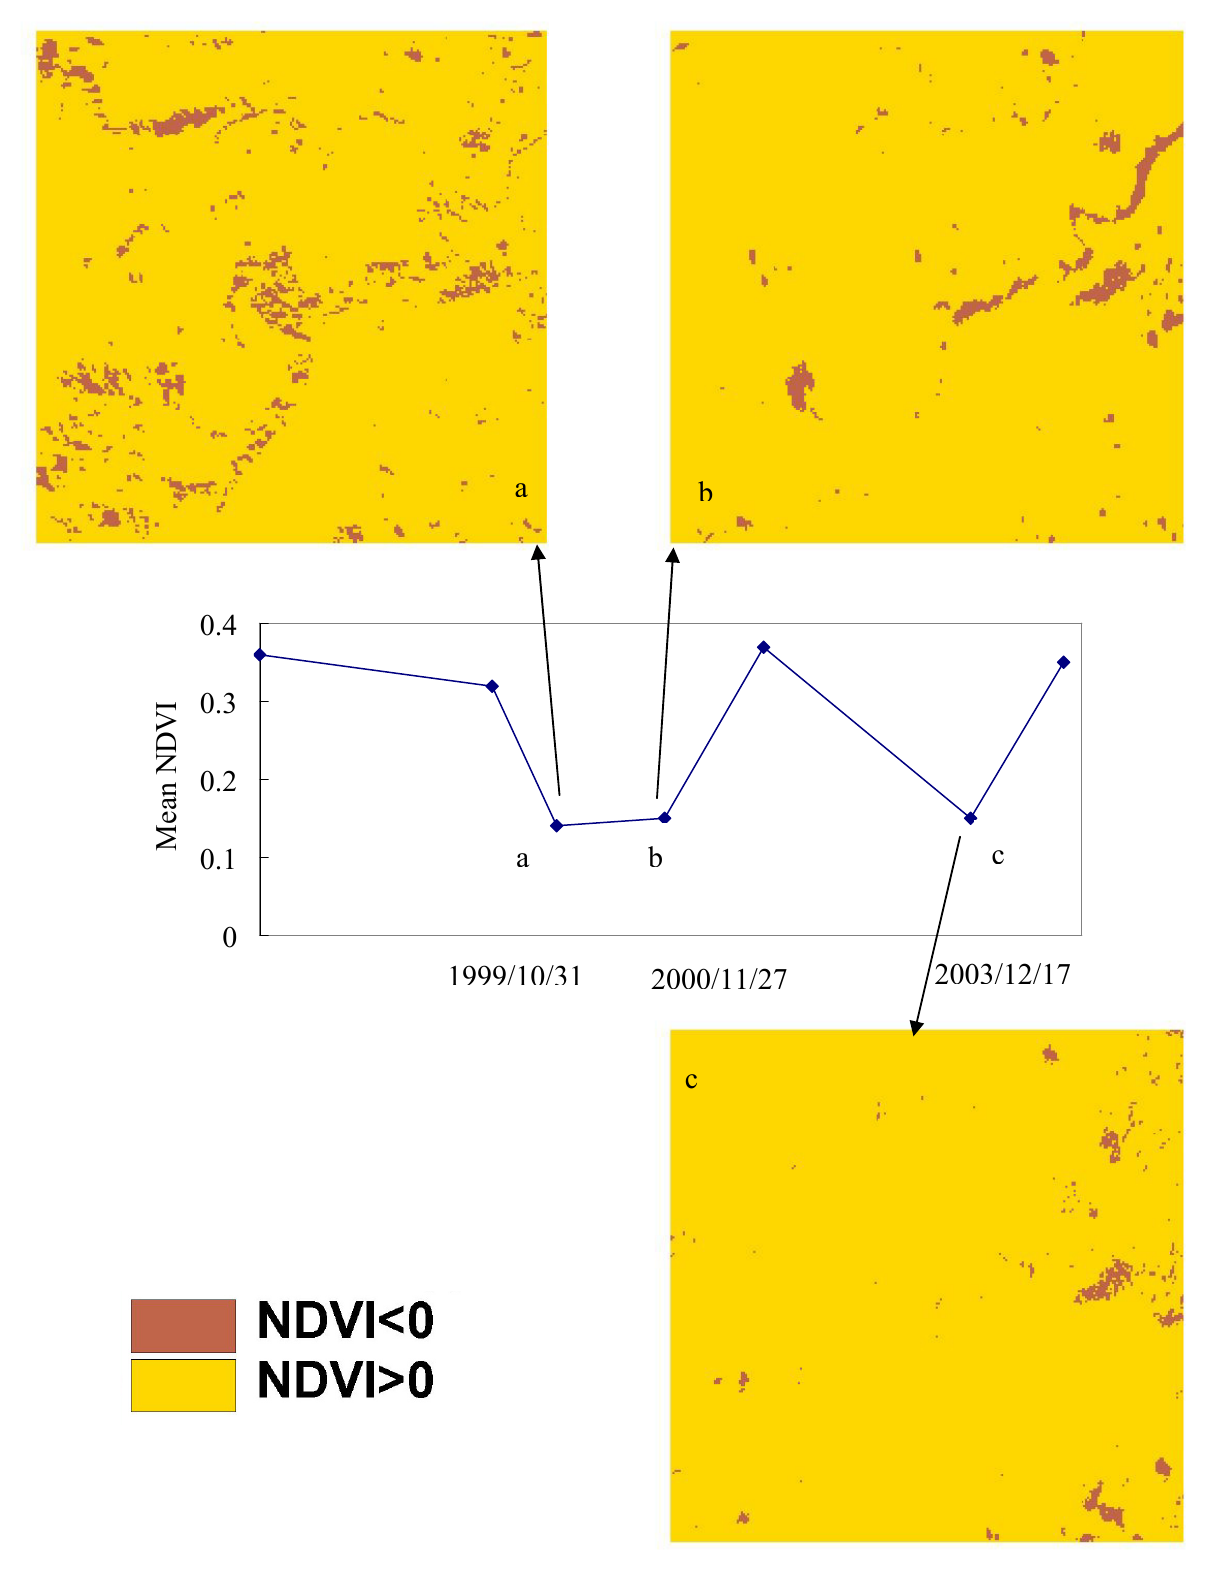
Figure 4. The NDVI classification data in three